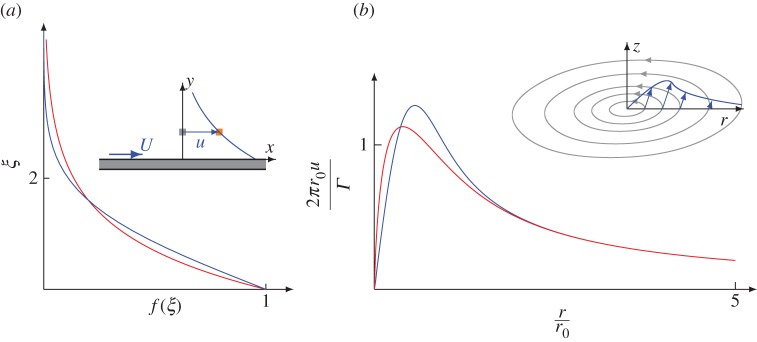
Resulting velocity profiles for (a) the flow over a suddenly moving plate and (b) the Lamb–Oseen vortex (at time t=πϱr02/25η). For both examples, the solution resulting from the equations of motion (2.9)–(2.11) (red) are compared to the respective profile resulting from the original Navier–Stokes equations (blue).